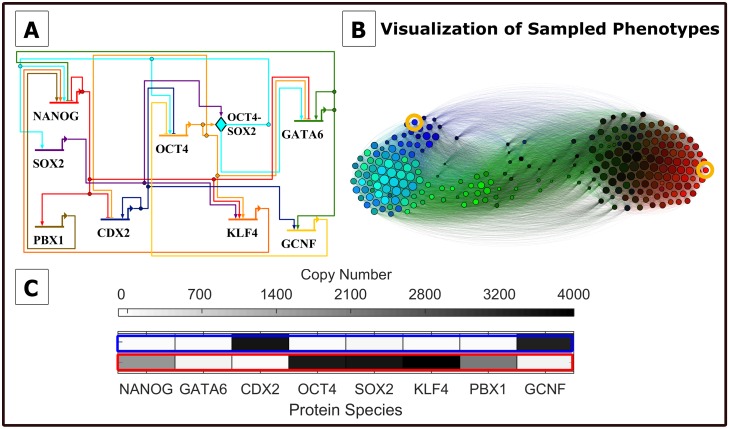
Pluripotency network model and simulation results (Parameter Set I).A)Wiring diagram for the eight-gene pluripotency network model, adapted from [28]. Arrowheads represent positive interactions, while flat lines denote repression. B) Simulation results: state-transition graph of sampled network states. Circles represent aggregate gene-expression states sampled during the Weighted Ensemble simulation. Circle areas are proportional to the steady-state probability πi in each state according to ln(γπi) with scaling factor γ = 3.4. States are colored according to the gene expression levels of three of the genes; red, green, and blue correspond to high NANOG, GATA6, and CDX2 expression respectively, while black corresponds to low or no gene expression. Edges connecting the states indicate possible state-transitions, colored according to the originating state. The graph is produced using Gephi [54] using a force-directed layout algorithm (Force Atlas), therefore short inter-state distances reflect higher probability of transitioning. C) Full protein compositions of two representative states, with either high CDX2 expression (blue) or high NANOG expression (red). States in (C) correspond to yellow circles in (B).